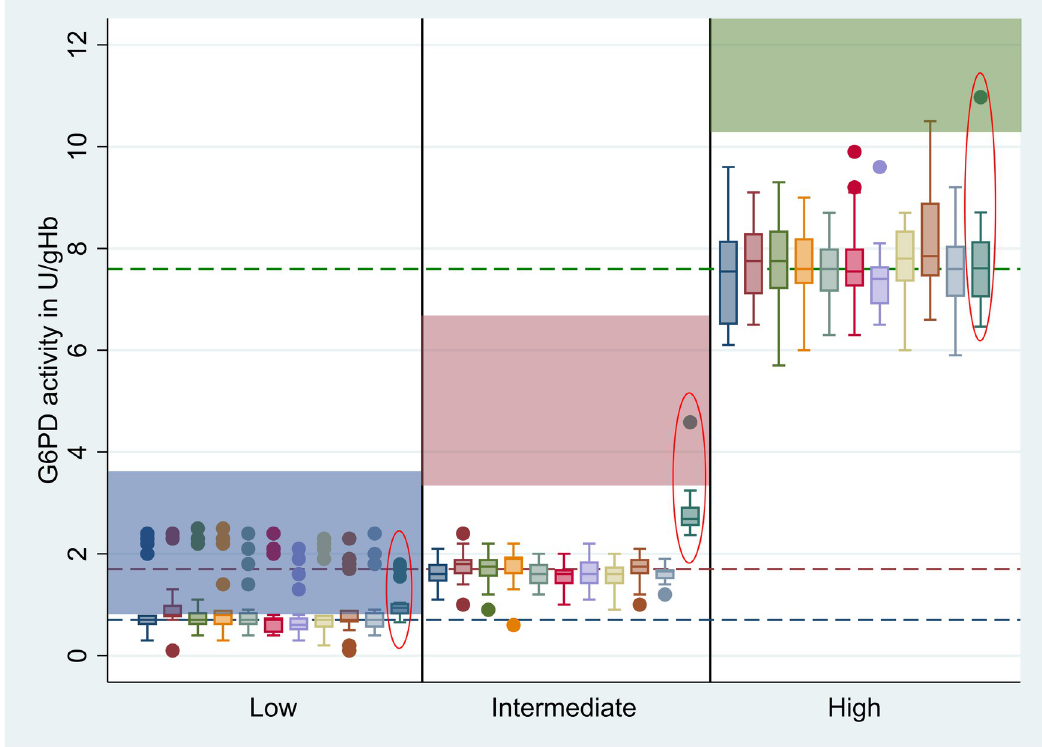
Fig 2. G6PD activity measured by each Biosensor device and spectrophotometry. Red circled bars = reference method (Hb normalized spectrophotometry result), Blue shade = recommended range for ACS Low controls, Red shade = recommended range for ACS Intermediate controls, Green shade = recommended range for ACS High controls, Blue dotted line = median activity of ACS Low controls across all devices excluding spectrophotometry, Red dotted line = median activity of ACS Intermediate controls across all devices excluding spectrophotometry, Green dotted line = median activity of ACS High controls across all devices excluding spectrophotometry, dots represent